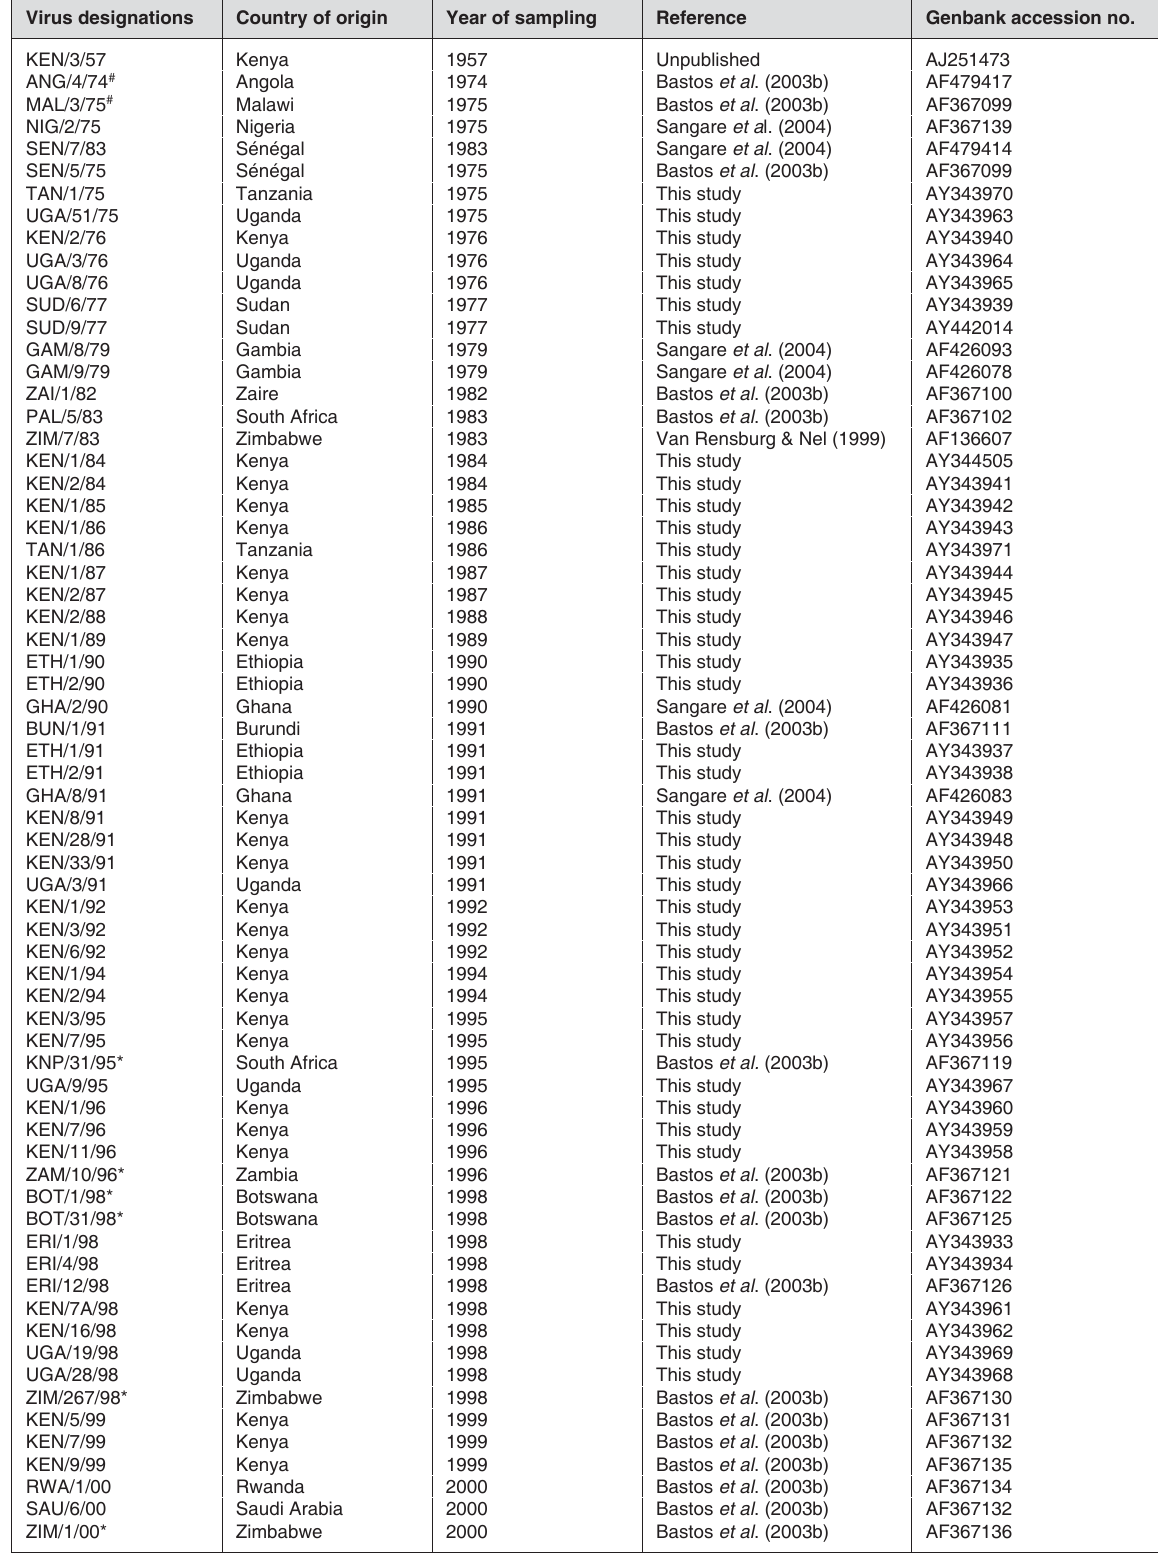
TABLE 1 Summary of SAT-2 FMD viruses included in this